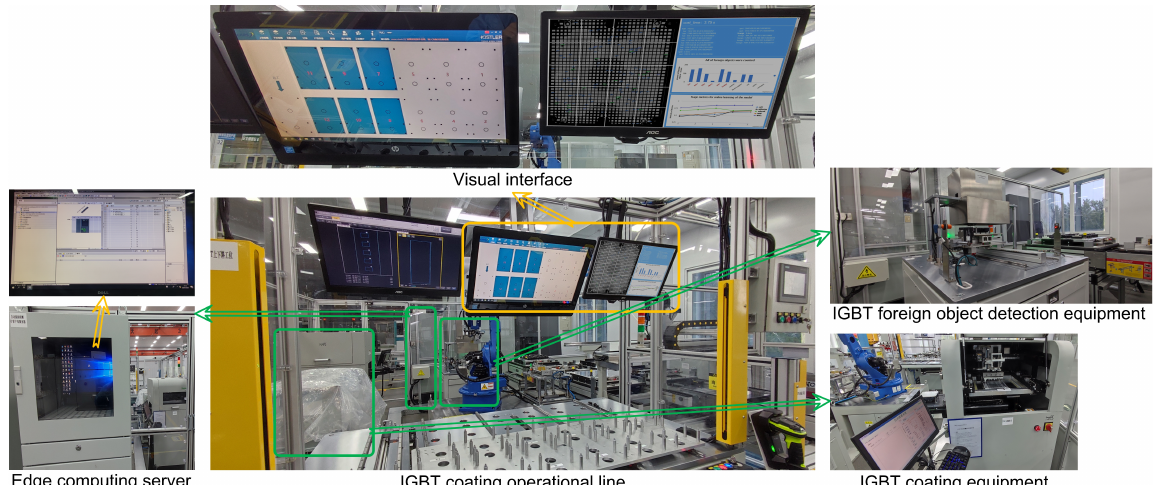
Figure 18. IGBT automatic glue coating detection production